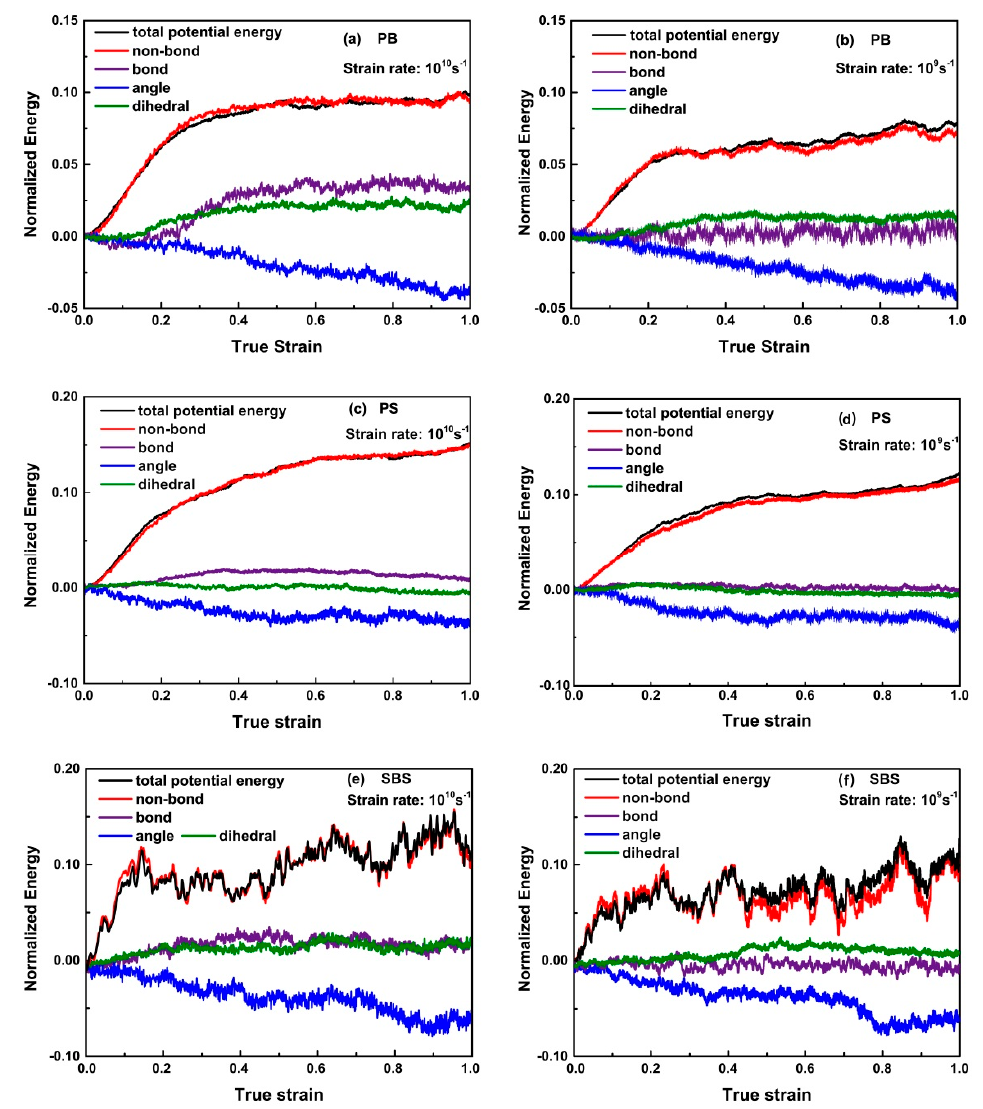
Figure 4. Evolution of normalized energy for: ( a,b ) PB; ( c,d ) PS; and ( e,f ) SBS at 100 K with strain rates of (cid:2013)(cid:4662) = 10 10 s − 1 and (cid:2013) (cid:4662) = 10 9 s − 1 . Herein, the total potential energy contains for items, i.e., the non-bond energy, bond length energy, bond angle energy, and dihedral energy.